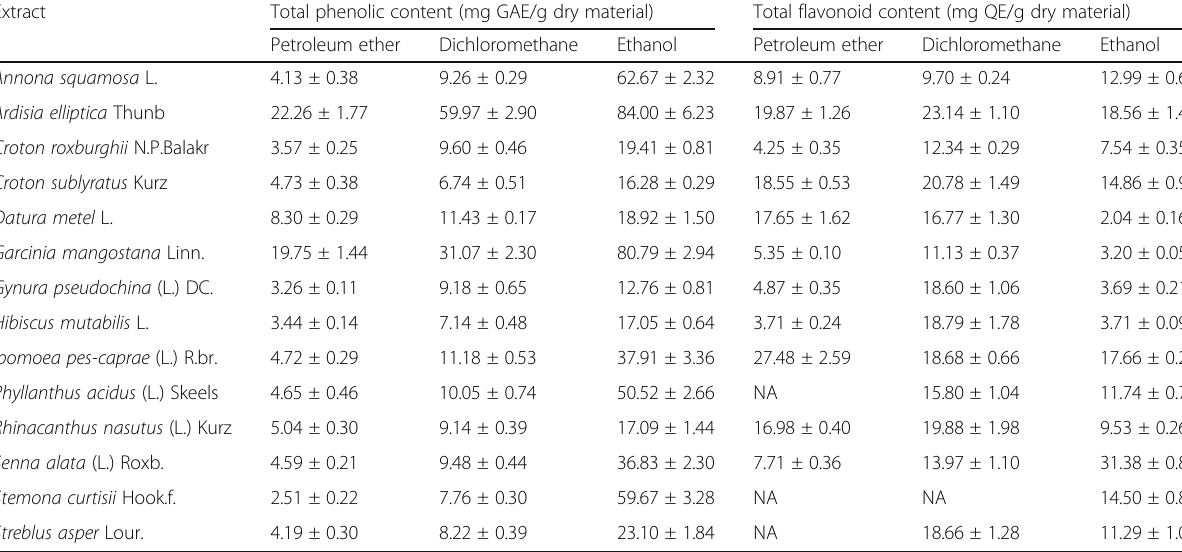
Table 2 Total phenolic and flavonoid contents of 14 Thai plants obtained from different solvents Extract Total phenolic content (mg GAE/g dry material) Total flavonoid content (mg QE/g dry material) Petroleum ether Dichloromethane Ethanol Petroleum ether Dichloromethane